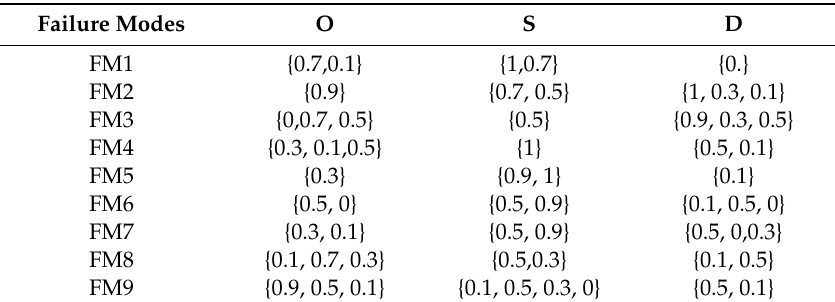
Table 9. Normalized hesitant fuzzy decision matrix.